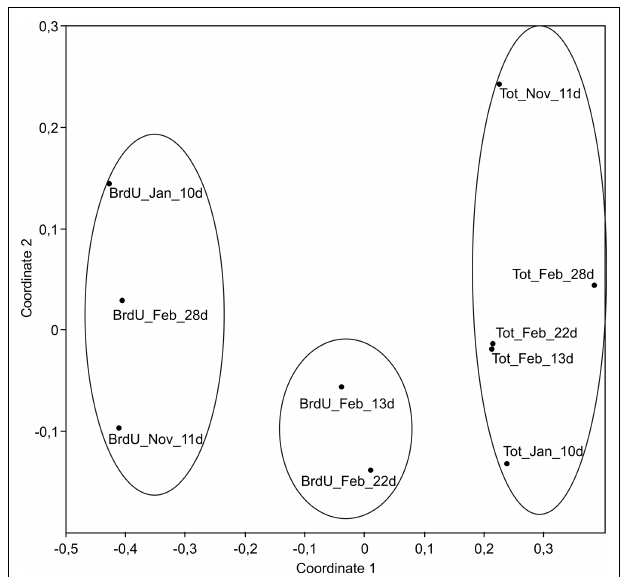
FIGURE 1 | Non-metric multidimensional scaling (NMDS) plots derived fromTRFLP peak intensity data showing similarity between active (BrdU) and total (Tot) bacterial communities. Date of sampling is indicated by the month: November (Nov), January (Jan), and February (Feb). Length of incubation is shown by the number of days (d). Circles indicate samples grouping at a 60% similarity level. Stress value =